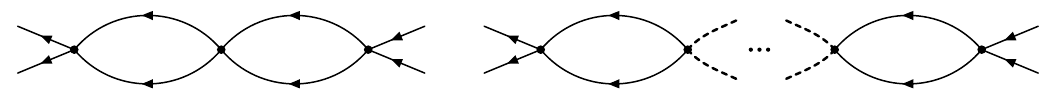
Figure 2 . Higher loop bubble diagrams for the two-body